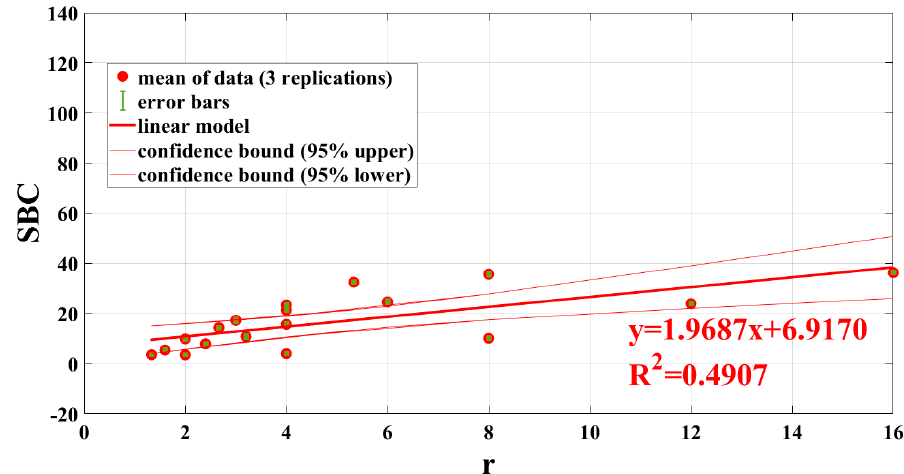
Figure 15. SBC versus r for PPT (phase) 128 frames, error bands and confidence bounds on the find linear model.